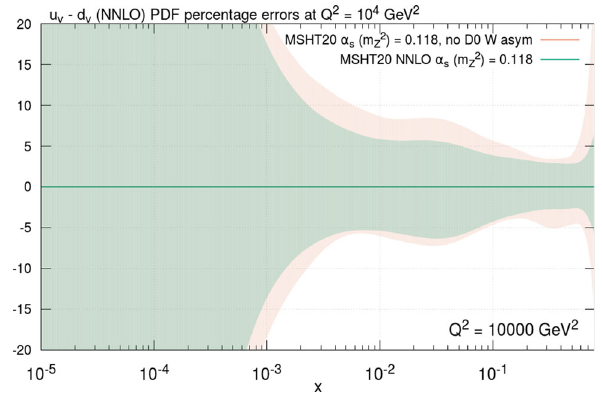
Fig. 61 u V − d V PDF percentage errors at Q 2 = 10 4 GeV 2 at NNLO in both the MSHT20 default fit and the same with the removal of the DØ W asymmetry data, and without fitting the electron